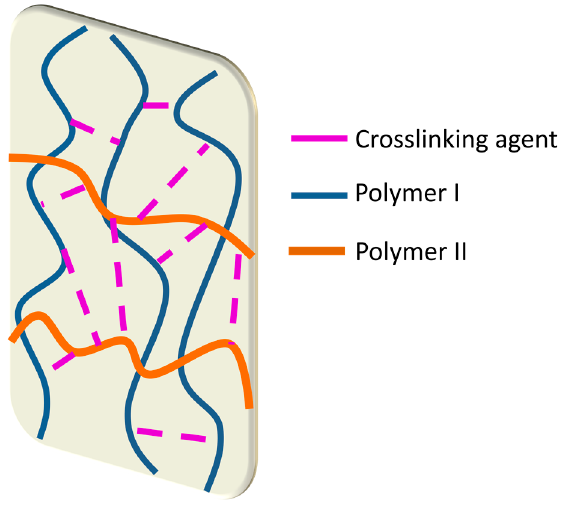
Figure 2. Structural model of an IPN hydrogel.